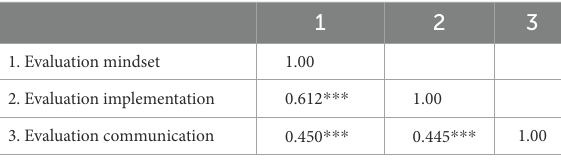
TABLE 5 Correlations between evaluation mindset, evaluation implementation, and evaluation communication ( n =